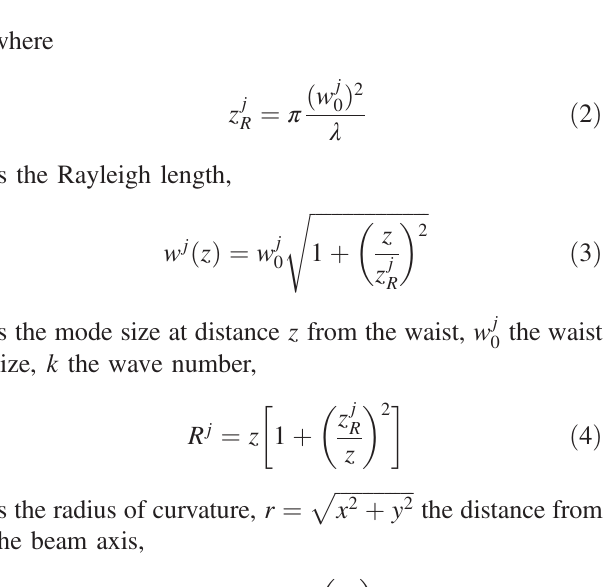
FIG. 4. Experimental FEL transverse spot profile for three different settings of the last phase shifter Δ ϕ emission of on-axis Gaussian mode, (b) intermediate and (c) the net emission is mainly off-axis. (d, e, f) Model predicted transverse radiation profile. The transverse spot profile was measured at a distance of ∼ 60 m from the exit of the last undulator. For the simulations, the parameters were λ ¼ 23 . 8 nm, w 0 ¼ 100 μ m, d ¼ 3 . 7 m, gain length 2.2